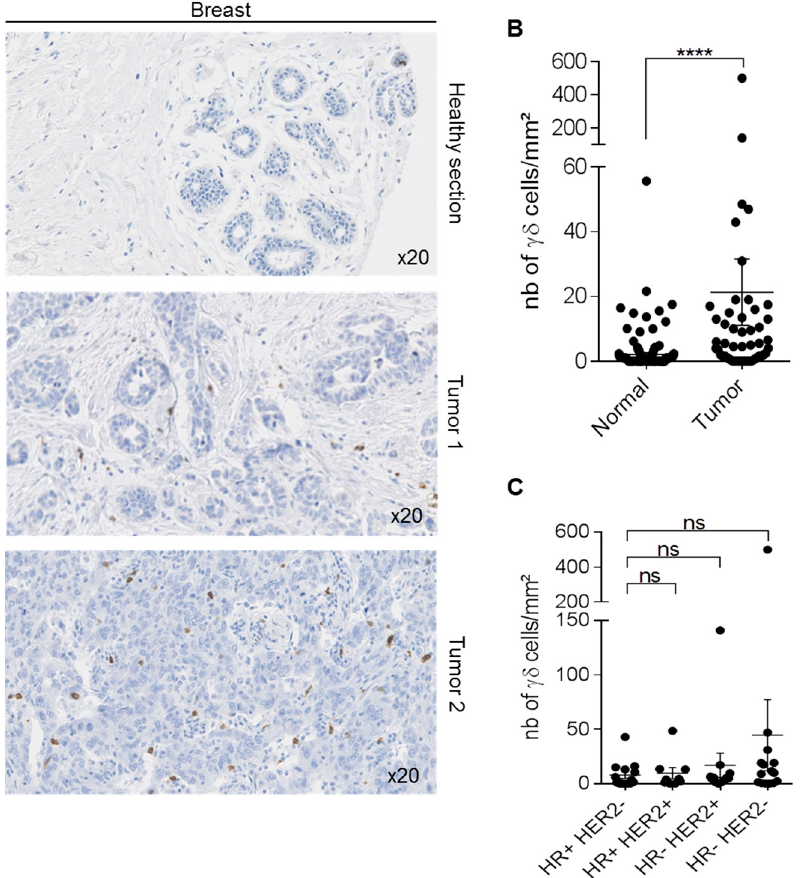
Figure 3. Detection of γδ T-cells in human breast samples. Immunohistochemical detection of γδ T-cells in 50 human breast cancer specimens. ( A ) One representative healthy breast area and two representative breast tumor sections with medium and high γδ T-cell density. ( B ) Scatter plot comparing γδ T-cell density in 141 normal breast samples and 50 breast tumors. ( C ) Scatter plot showing γδ T-cell density in 50 breast cancer samples, according to their hormone receptor (HR) and epidermal growth factor receptor 2 (HER2) status. Data are the mean ± SEM. **** p < 0.0001 (Mann–Whitney test for panel B); ns: non-significant (Kruskal–Wallis with Dunn’s multiple comparison test for panel C).